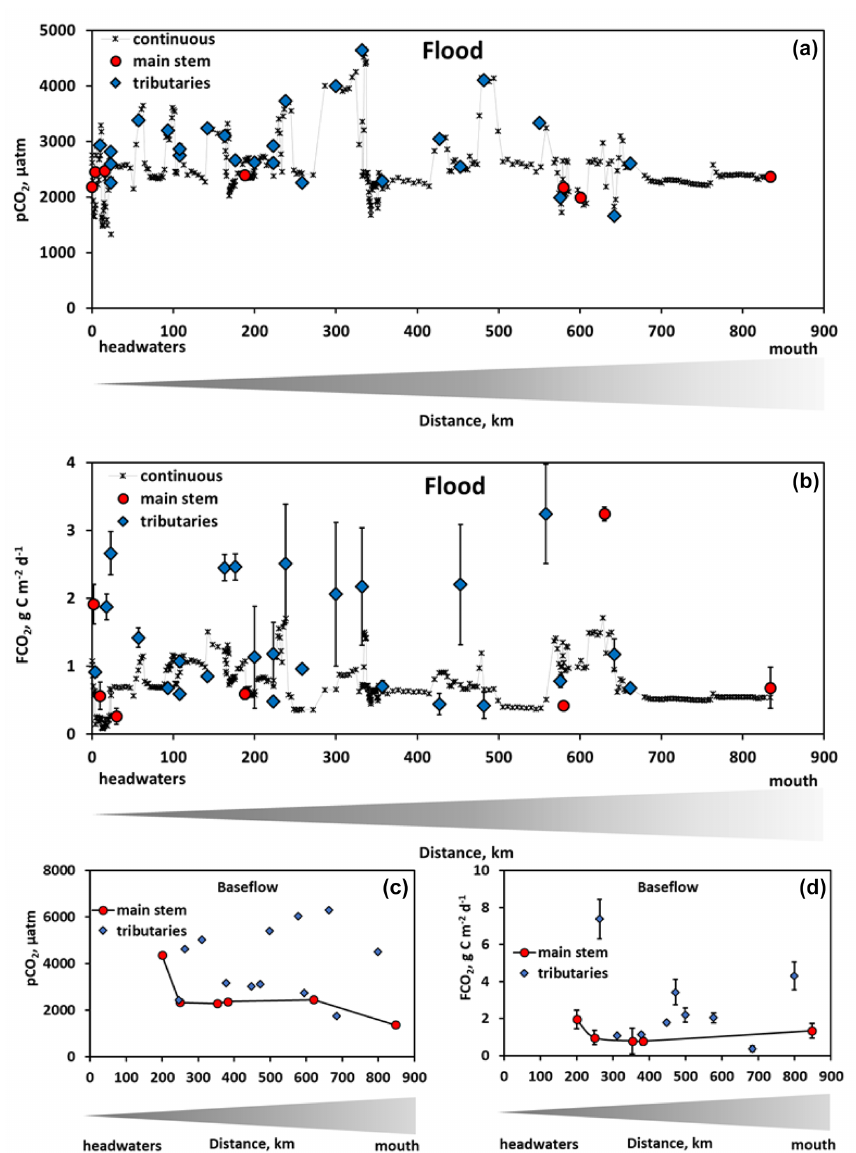
Figure 2. The measured p CO 2 (a, c) and CO 2 fluxes (b, d) during spring flood (a, b) and summer baseflow (c, d) of the Ket River main stem and tributaries (over the 830km distance, from the headwaters to the mouth – left to right). The symbols represent discrete in situ p CO 2 (Vaissala) and F CO 2 (floating chamber) measurements of the main stem (red circles) and tributaries (blue diamonds). Continuous in situ p CO 2 measurements and calculated F CO 2 are available only for the main stem in spring (black crosses). For the latter, we used an average value of measured gas transfer velocity ( K T ) between two chamber sites (separated by a distance of 50 to 100km) to calculate the F CO 2 from in situ measured p CO 2 in the river section between these two sites. Note that, during summer baseflow, the water level did not allow the headwaters of the Ket River to be reached (first 0–200km on the river